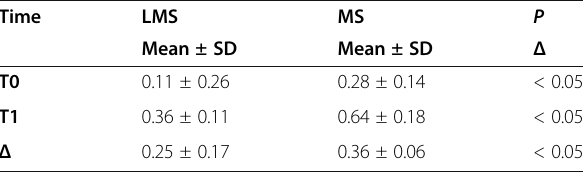
Table 6 Peri-implant radiographic bone levels (mm) detected in the LMS and MS